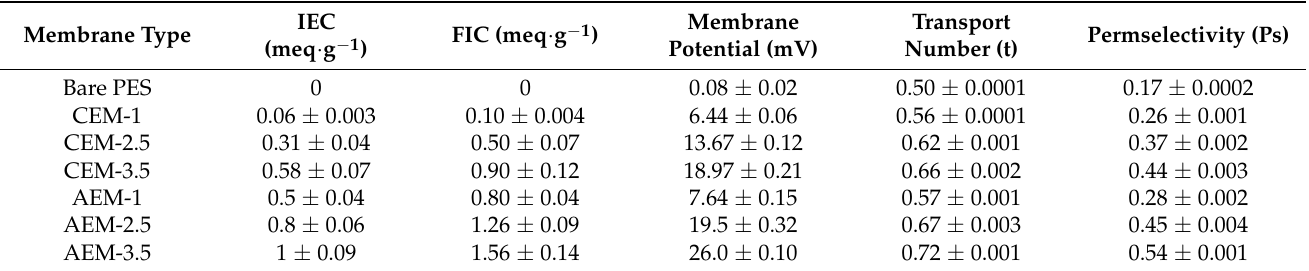
Table 3. Ion exchange capacity (IEC), FIC, membrane potential, transport number and permselectivity of the prepared bare PES membrane, CEMs and